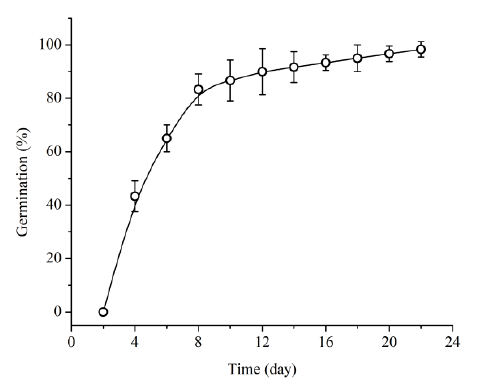
Figure 2. Percentage of cumulative germination of Quercus chungii seeds initiating germination at room temperature.